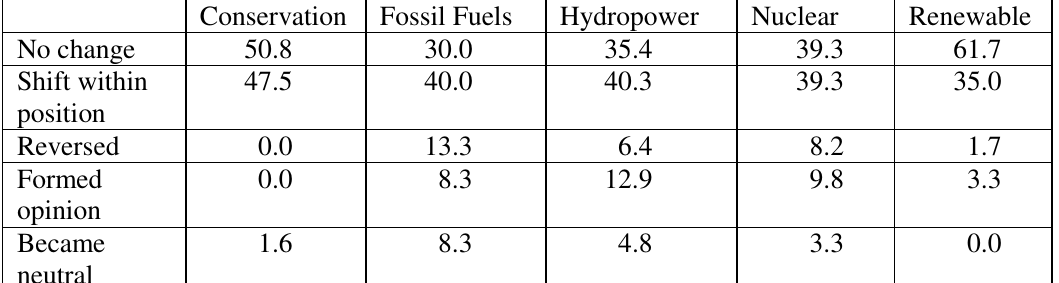
Table 4. Percentage of Participants Exhibiting Changes in Ratings of Energy Options between Pre-test and Post-test (n=61) Conservation Fossil Fuels Hydropower Nuclear Renewable No change 50.8 30.0 35.4 39.3 61.7 Shift within 47.5 40.0 40.3 39.3 35.0 position Reversed 0.0 13.3 6.4 8.2 1.7 Formed 0.0 8.3 12.9 9.8 3.3 opinion Became 1.6 8.3 4.8 3.3 neutral